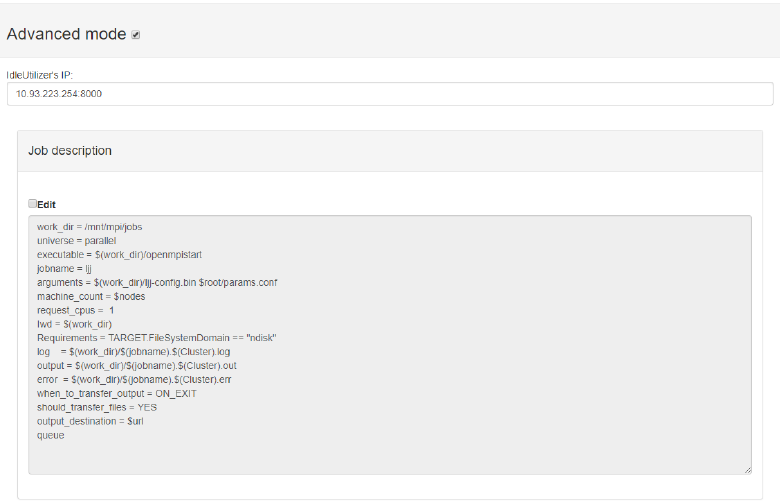
Fig. 6. A screenshot of the advanced mode on the tab “Creating a job”